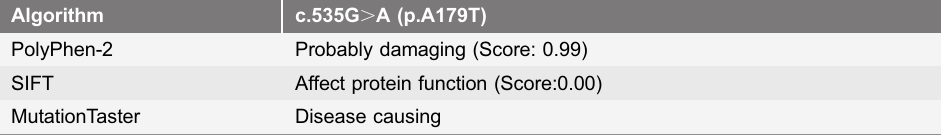
Table 2. Functional prediction for the TMPRSS3 missense mutation, c.535G .